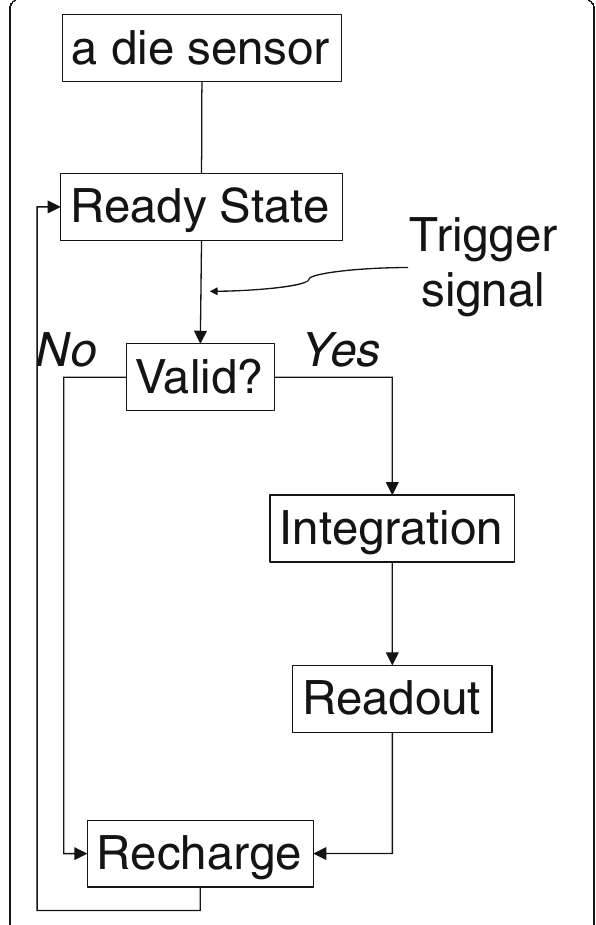
Fig. 2 Single event-based data acquisition sequence on each die sensor of the investigated DPC PET